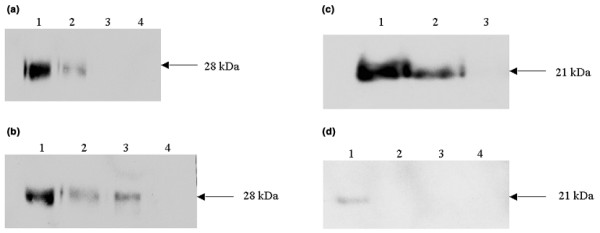
MCF-7 and MDA-MB-231 upregulation of TIMP-1 and TIMP-2 protein levels from THP-1 monocytes. Immunoblots representative of three independent experiments carried out in duplicate using monoclonal (a,b) TIMP-1 and (c,d) TIMP-2 antibodies to show an increased production of both proteins by monocyte cells in response to MCF-7 and MDA-MB-231 CM. Lane 1 contains CM from THP-1 cells in serum-free media grown in the presence of 300 μl concentrated (a,c) MCF-7 CM and (b,d) MDA-MB-231 CM. Lane 2 contains CM from THP-1 cells in serum-free media grown in the presence of 300 μl concentrated serum-free media. Lane 3 contains serum-free media with 300 μl of (a,c) MCF-7 CM and (b,d) MDA-MB-231 CM in the absence of THP-1 cells. Lane 4 contains unconcentrated (a) MCF-7 and (b,d) MDA-MB-231 CM.